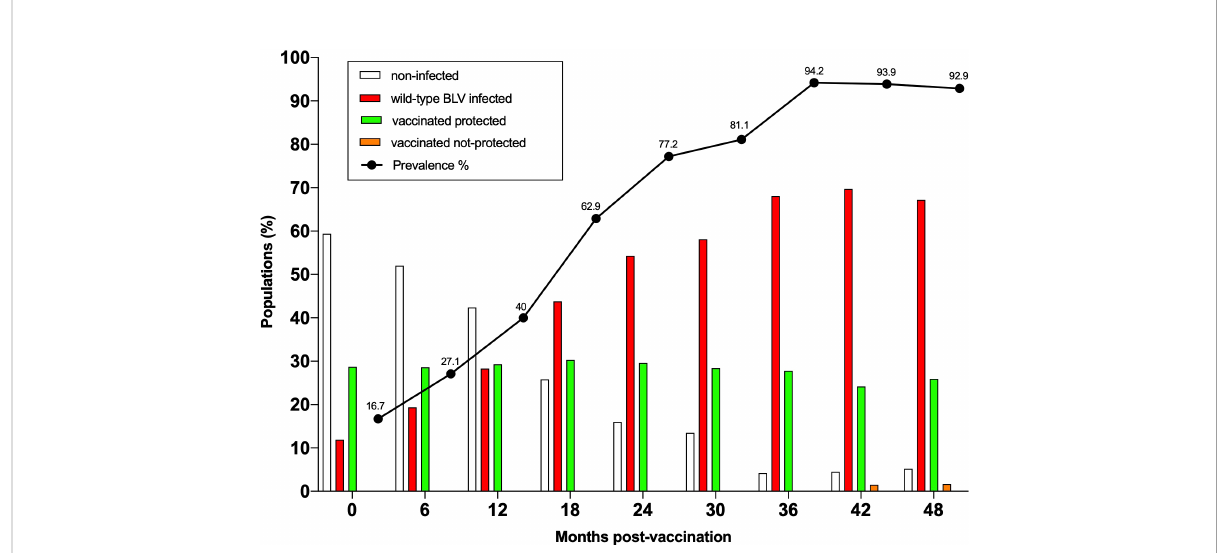
FIGURE 4 The vaccine is effective despite high incidence of BLV infection. The BLV prevalence indicated by the black line was determined at 6 months intervals from birth up to 4 years of age. The percentages of non-infected and BLV-infected animals are indicated by empty and red bars, respectively. In these conditions, vaccinated animals remained protected from wild-type BLV infection (green). Only one out of 29 vaccinated animals became infected with wild-type BLV at 42 months (vaccinated not-protected in